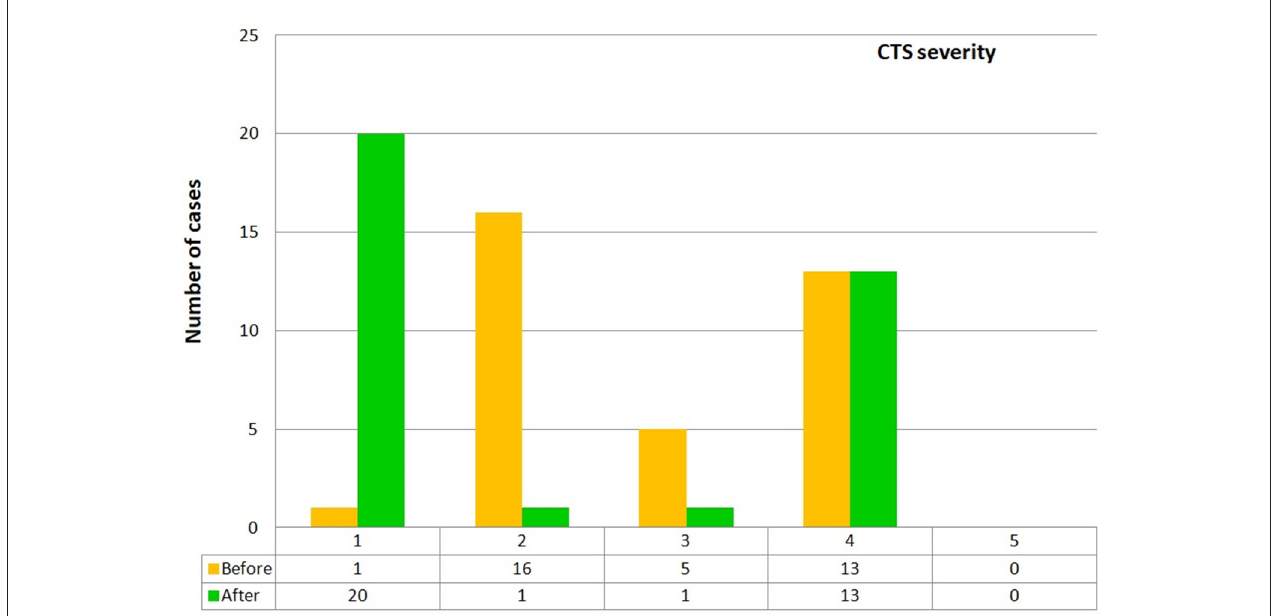
FIGURE 1 | CTS severity on the Hi-Ob scale before and after surgery.